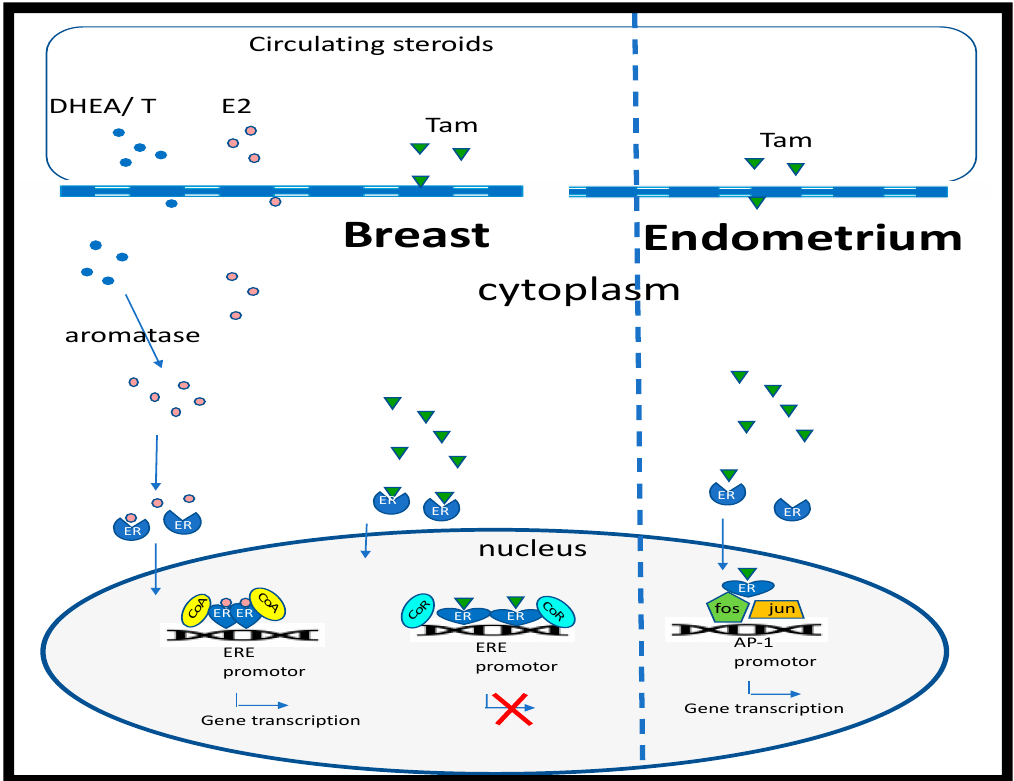
Figure 1. Regulation of estrogen ‐ response genes by 17 β‐ estradiol and tamoxifen. Estradiol (E2) (pink circles) passes through the cell membrane and binds to the estrogen receptor (ER), inducing a conformational change in shape and nuclear translocation, where it interacts with specific estrogen response elements (ERE) that regulate estrogen responsive genes, after recruiting cell ‐ specific cofactors (CoA). E2 can be metabolized by aromatase from androgen precursors (blue circles; dehydroepiandrosterone (DHEA) or testosterone (T)). In breast cells, binding of tamoxifen (Tam) to ERs results in a conformational change that recruits corepressors (CoR) of gene transcription. However, in the endometrium, tamoxifen binding to the ER results in protein:protein interactions and activation of the activator protein 1 (AP ‐ 1) promotor.